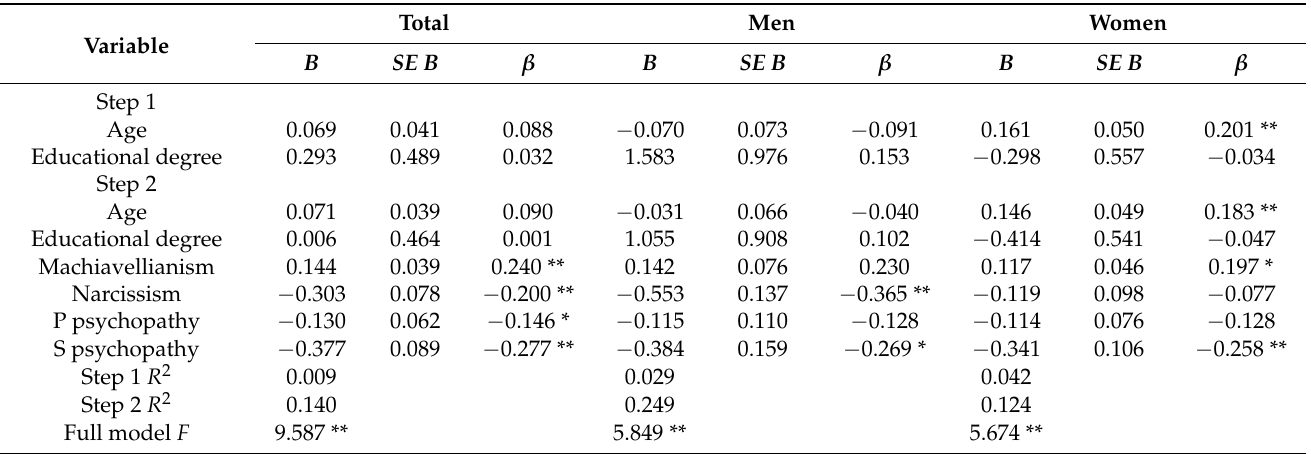
Table 4. Multiple regression of Dark Triad traits on uncontrolled eating by sex.